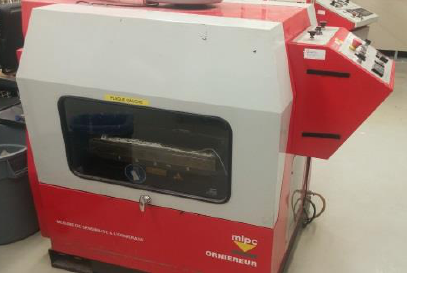
Figure 7. The French rutting test equipment.